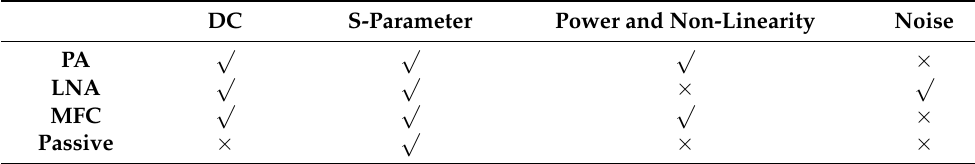
Table 2. Different MMICs’ test